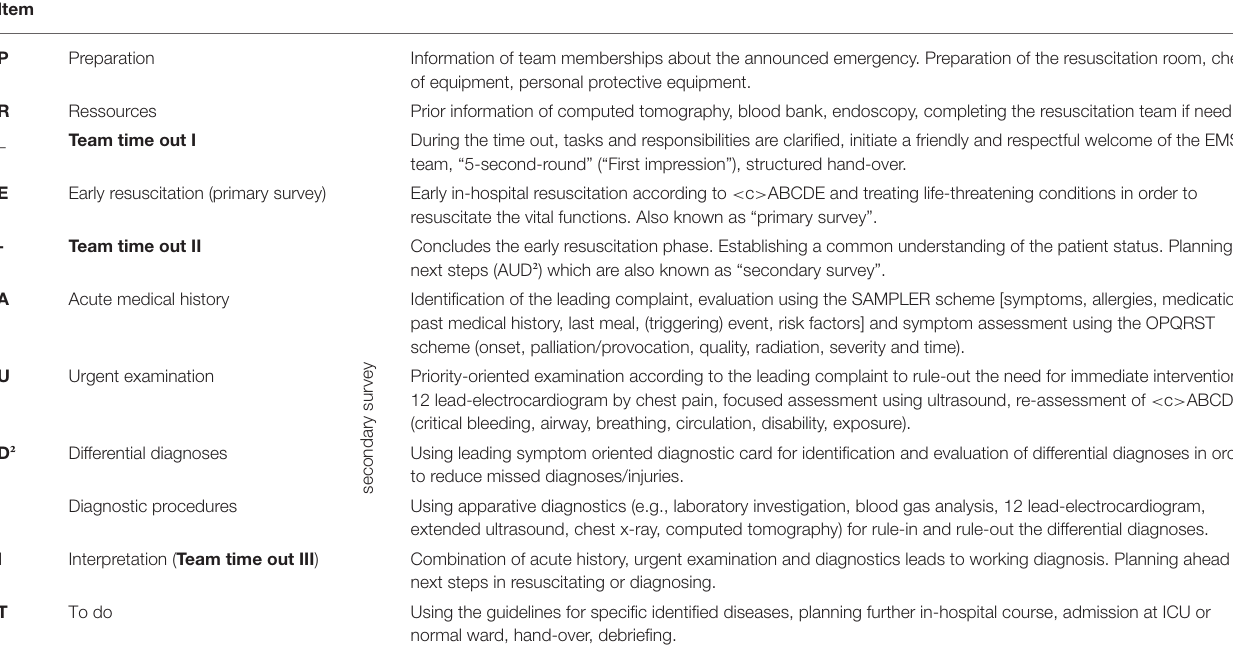
TABLE 2 | The (PR_E-)AUD 2 IT-algorithm as backbone of the resuscitation room management of critically ill patients.